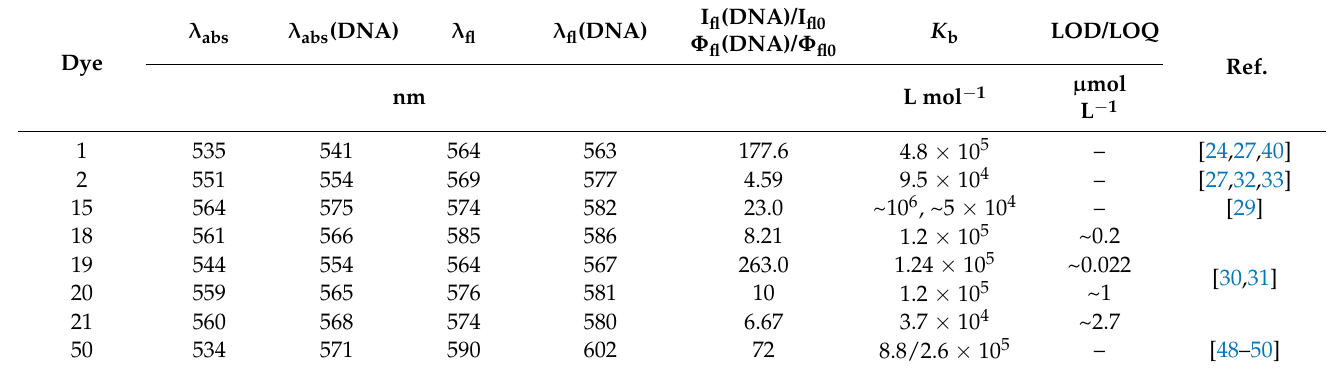
Table 2. Spectral-fluorescent properties of trimethine cyanine dyes free and in a complex with DNA (in the presence of high concentrations of DNA): maxima of the absorption and fluorescence spectra λ abs , λ fl , λ abs (DNA), and λ fl (DNA), respectively, ratios of fluorescence intensities/quantum yields in the presence and in the absence of DNA I fl (DNA)/ I fl0 or Φ fl (DNA)/ Φ fl0 , and dye–DNA binding constants K b and limits of detection/quantification of DNA LOD/LOQ using the dyes as probes.